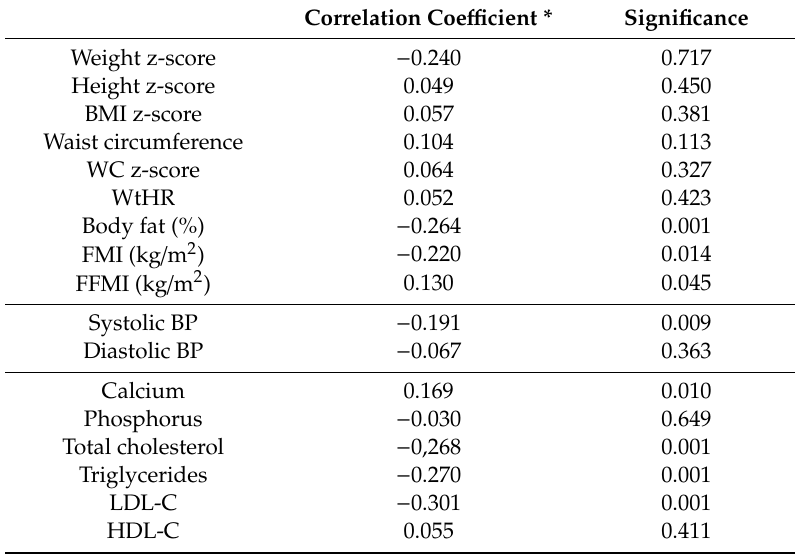
Correlations of 25(OH)D with anthropometric and biochemical characteristics in bivariate